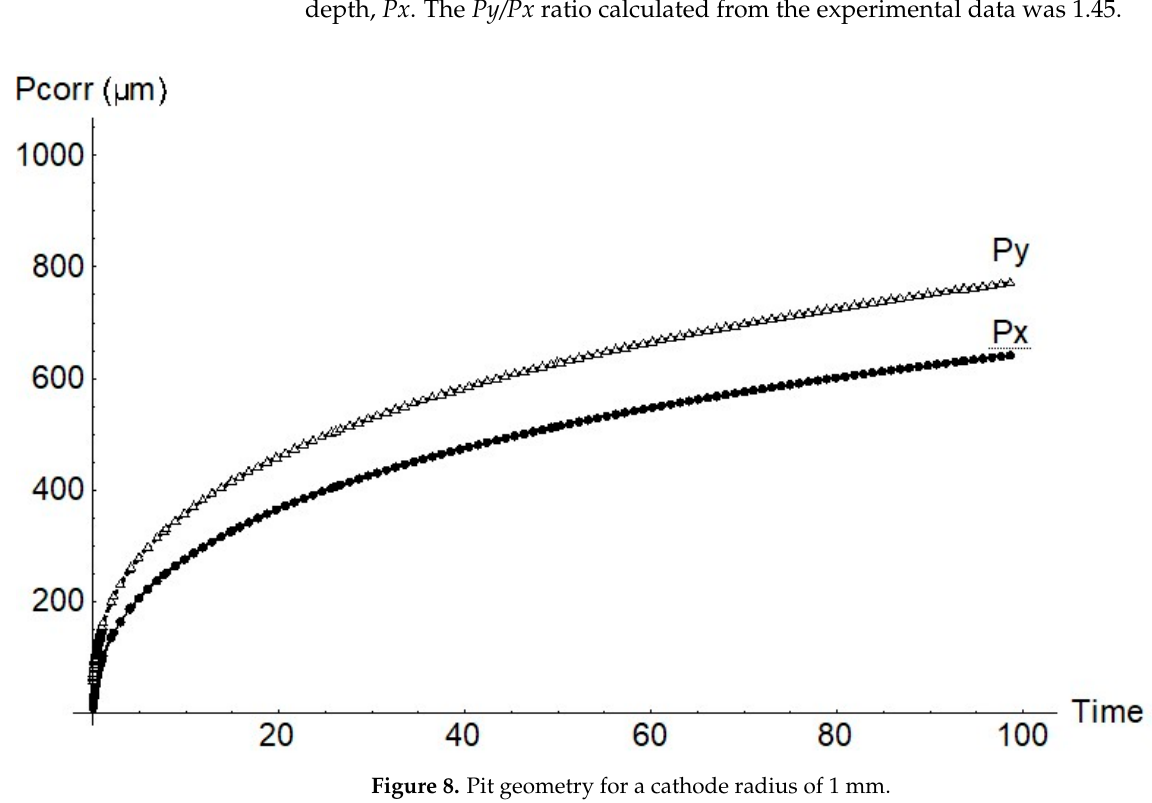
Figure 7. Variation in pit depth, Px , over time for different cathode areas and radii, Rc , and comparison with experimental values (red circles).